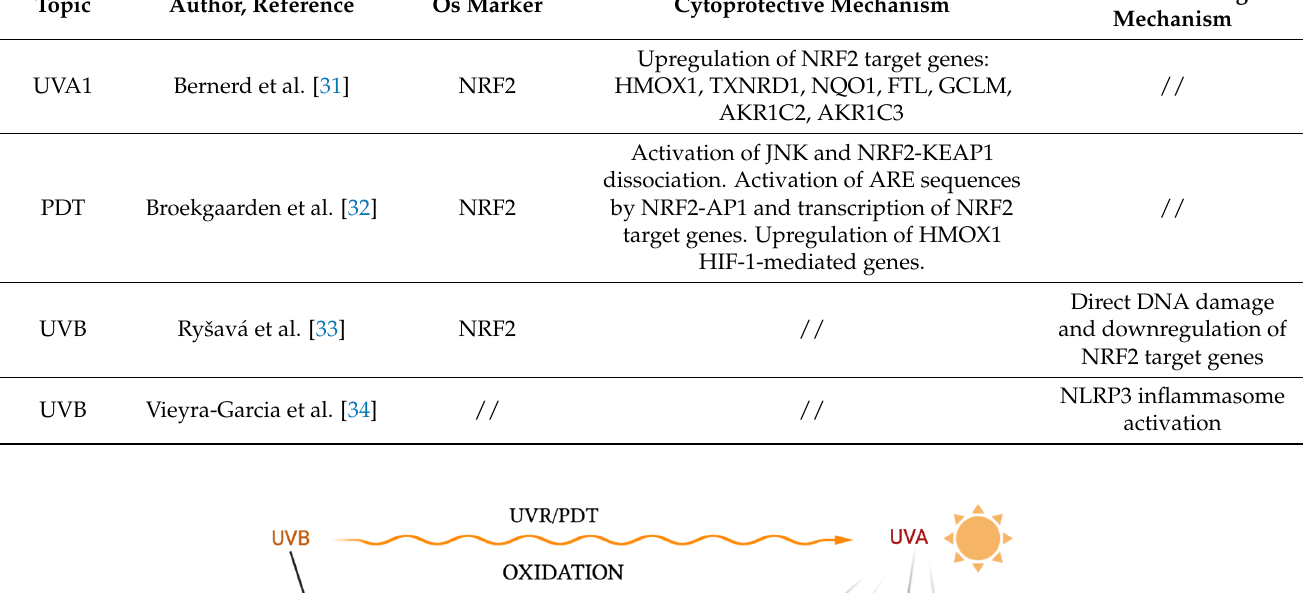
Table 1. Study characteristics.